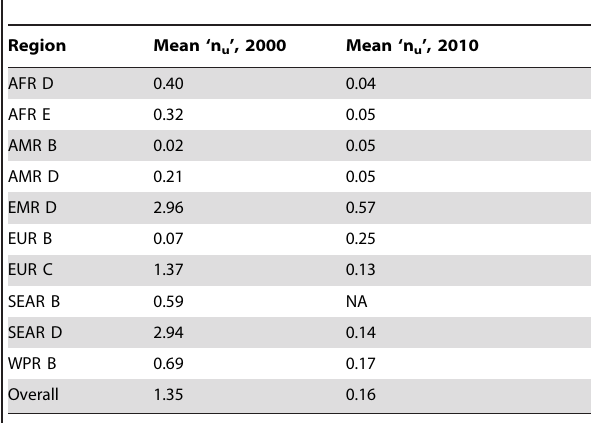
Table 4. Number of unsafe healthcare injections per person per year (‘n u ’) in each region, 2000 and